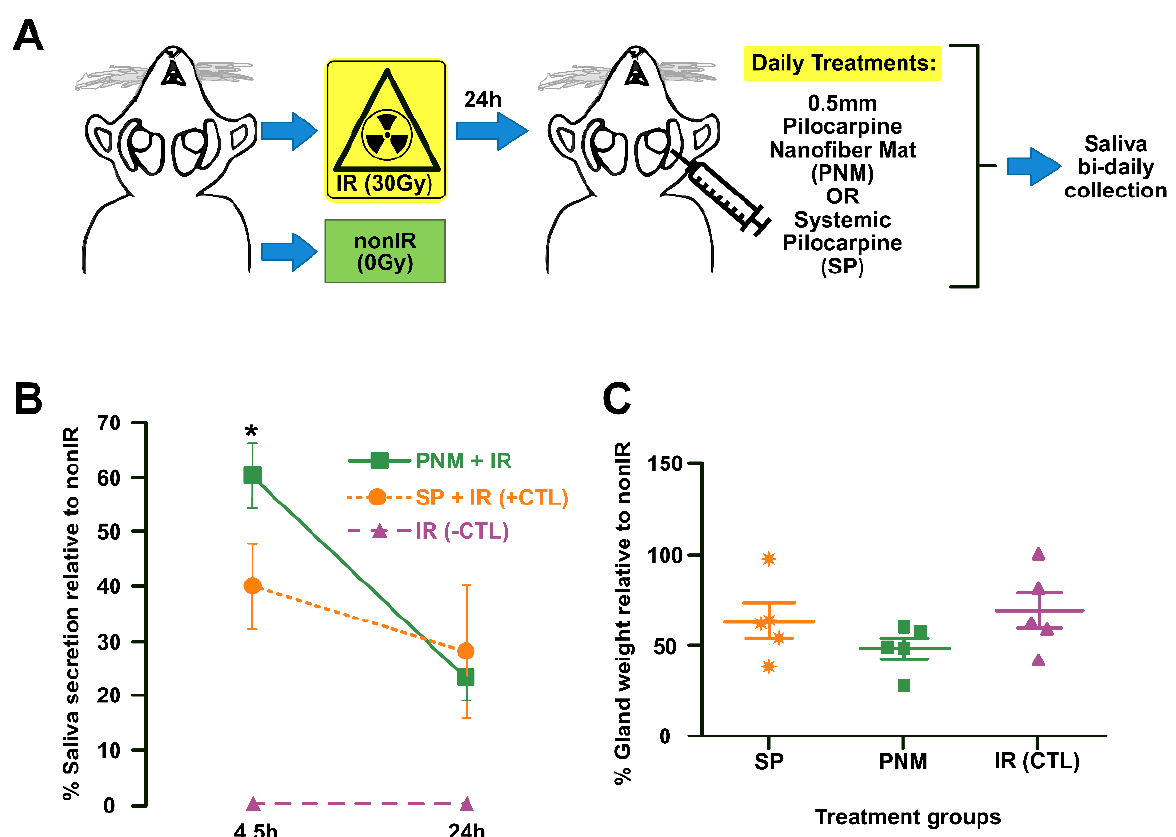
Figure 6. Schematic drawing of the in vivo salivary glands hypofunction model ( a ), one day saliva secretion rate after administration of the pilocarpine nanofiber mats (PNM) and the orally administrated systemic pilocarpine (SP) ( b ) and salivary gland weight remained unchanged PNM administration ( c ). Error bars represent SEM from n = 4 − 5. * p < 0.05 when compared to irradiated group with systemic pilocarpine only (SP, which represents the positive CTL). IR: irradiated (negative CTL). nonIR: non-irradiated control group. SGs: salivary glands. Adapted from [92].